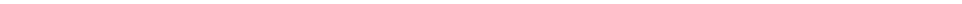
Table 3. Variant extraction results on the Variome corpus. Results for exact and partial matching are present. Each row shows the performance of each method in terms of true positives (TP),